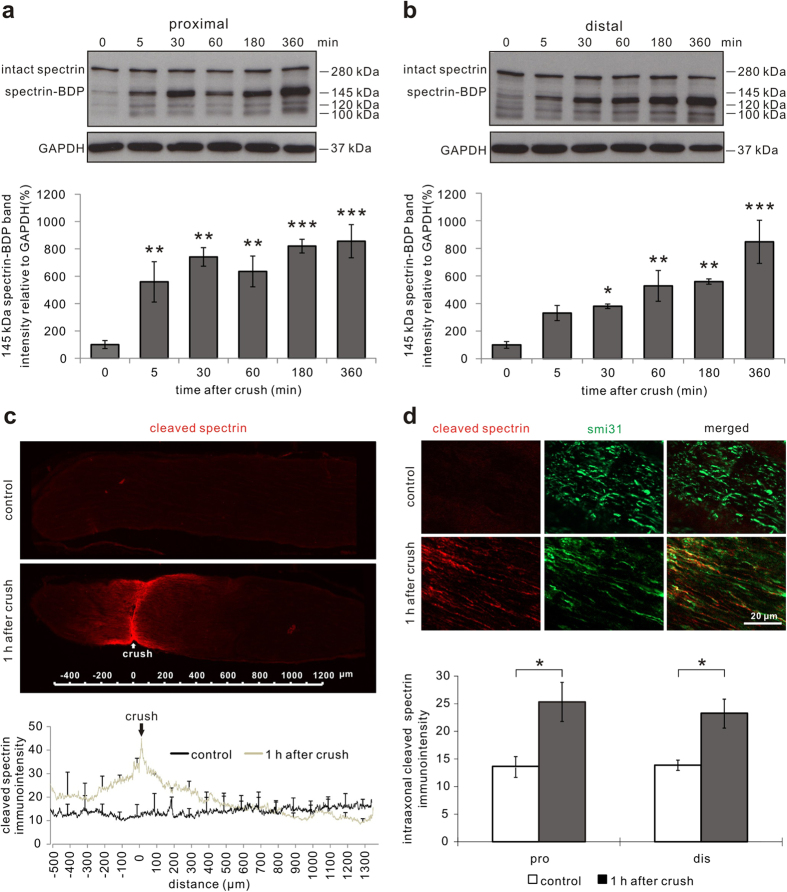
Calpain-mediated spectrin proteolysis during acute axonal degeneration after optic nerve crush in vivo.(a,b) Representative Western blots of spectrin proximal (a) and distal (b) to the crush site in the optic nerves at indicated time points after crush and uncrushed optic nerves (0 min after crush). Below, the quantification of the 145 kDa cleaved spectrin band is depicted, which represents the breakdown product (BDP) of spectrin specifically attributed to calpain cleavage, normalized to GAPDH. 3–6 optic nerves are included at each time point. Error bars represent the standard error of the mean (SEM). Differences are considered significant with *P < 0.05, **P < 0.01, ***P < 0.001 by one-way ANOVA and Dunnett’s test. (c) Overview images (20×) of a native uncrushed optic nerve (control) and an optic nerve at 1 h after crush immunostained against cleaved spectrin. The antibody against cleaved spectrin selectively detects the calpain-specific BDP of spectrin. Below, quantification of the staining intensity along the longitudinal sections of native optic nerves and optic nerves at 1 h after crush. (d) Higher magnification micrographs of the representative areas immunostained against cleaved spectrin and the axonal marker smi31 in a native optic nerve and within 300 μm of the crush site in an optic nerve at 1 h after crush. Below, quantification of the intensity of intra-axonal cleaved spectrin up to 300 μm proximal and distal to the crush site. 3 optic nerves per group. *P < 0.05 by independent samples t-test.